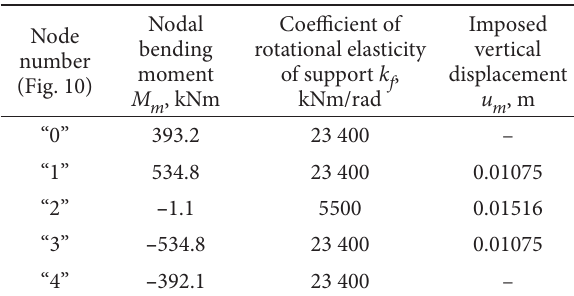
Table. 4. Data for computation of bending moments in rigid flange (stage II of analysis)